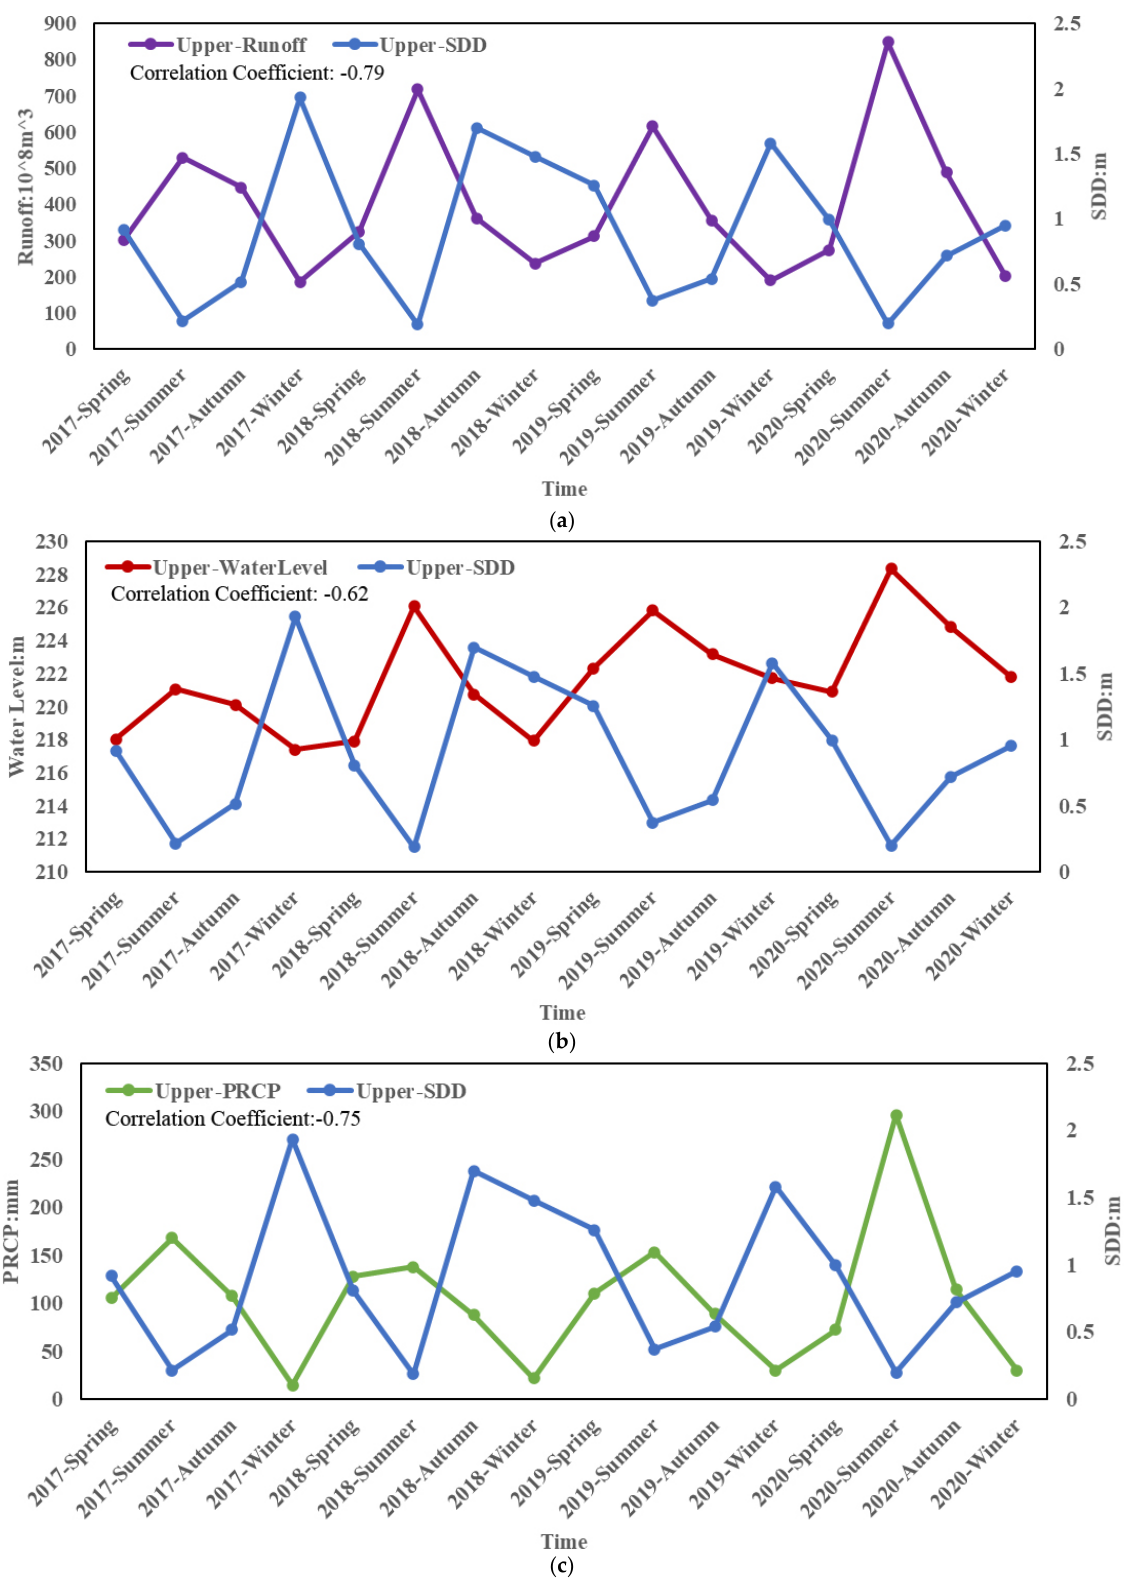
Figure 10. The relationship between the upper reaches of the Yangtze River and runoff, water level, PRCP; ( a ) the relationship between the SDD and runoff; ( b ) the relationship between the SDD and water level; ( c ) the relationship between the SDD and